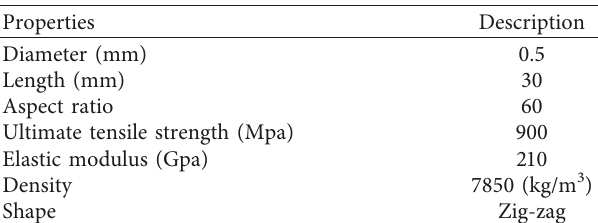
Figure 1: Particle size distribution of steel slag with normal aggregate. Table 2: Properties of steel